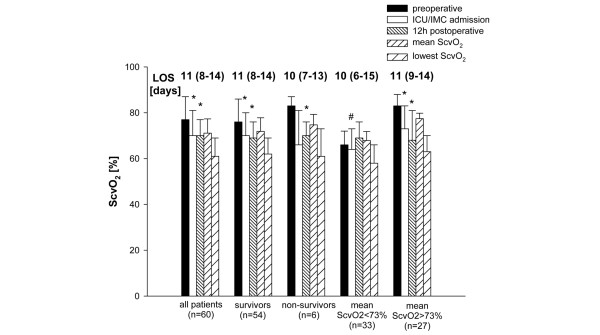
Central venous oxygen saturation (ScvO2) (percentage) in survivors and non-survivors and in patients with high and low mean ScvO2 values. The numbers above the error bars indicate the corresponding LOS data for the different sub-groups. *Wilcoxon signed rank test versus preoperative (p < 0.05). #Mann-Whitney test versus ScvO2 >73% (p = 0.001). ICU/IMC, intensive care unit/intermediate care unit; LOS, length of stay in hospital.